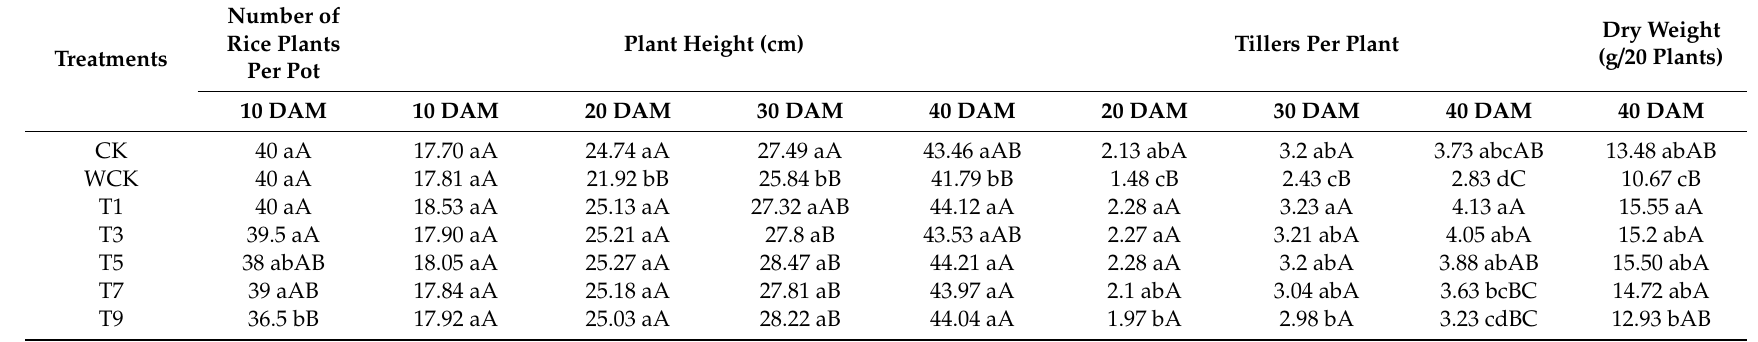
Table 1. E ff ects of oilseed rape straw mulch in simulated direct-seeded